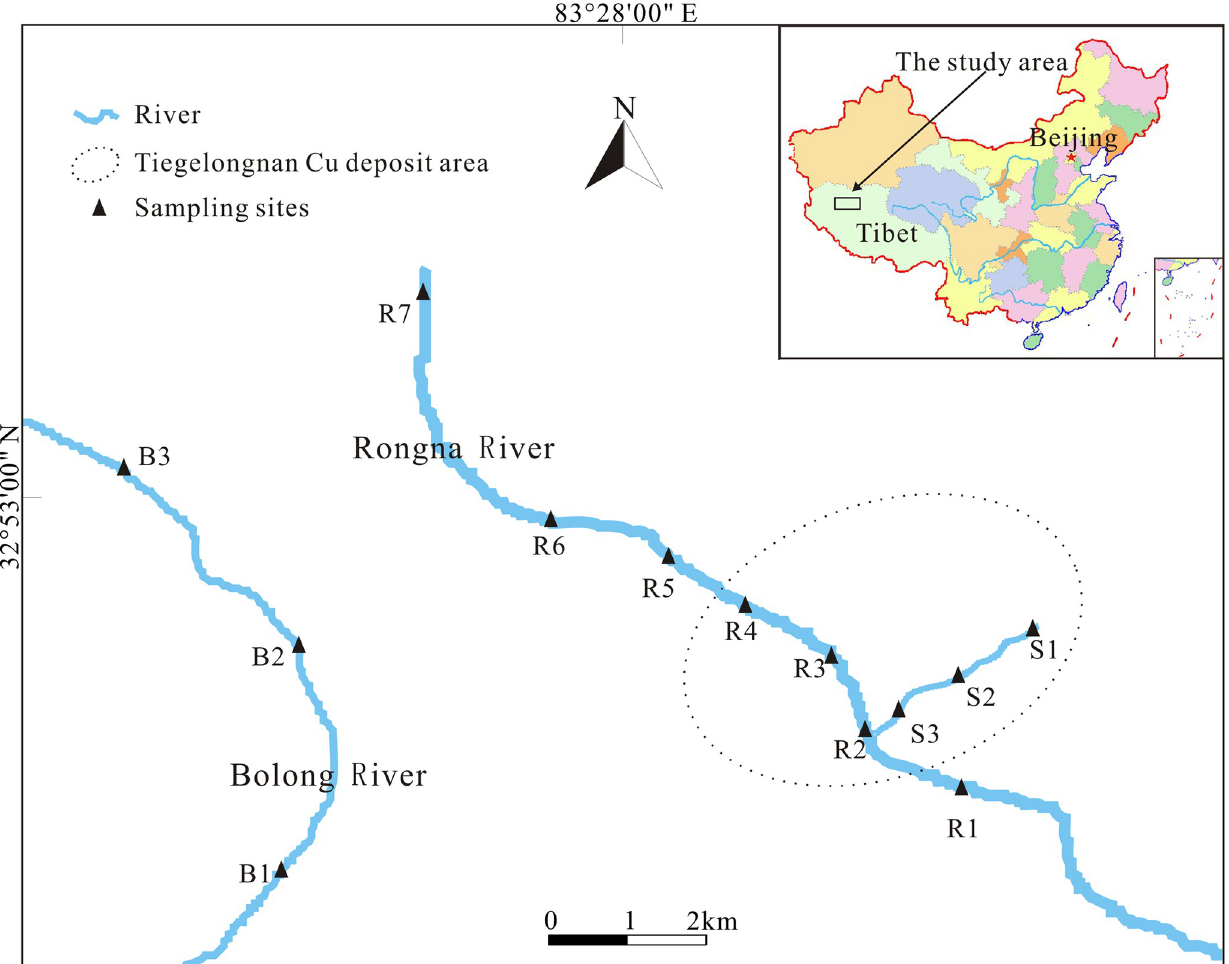
Fig 2. Location of the study area and the distribution of sampling points. The location coordinate map of the study area was drawn according to the USGS National Map